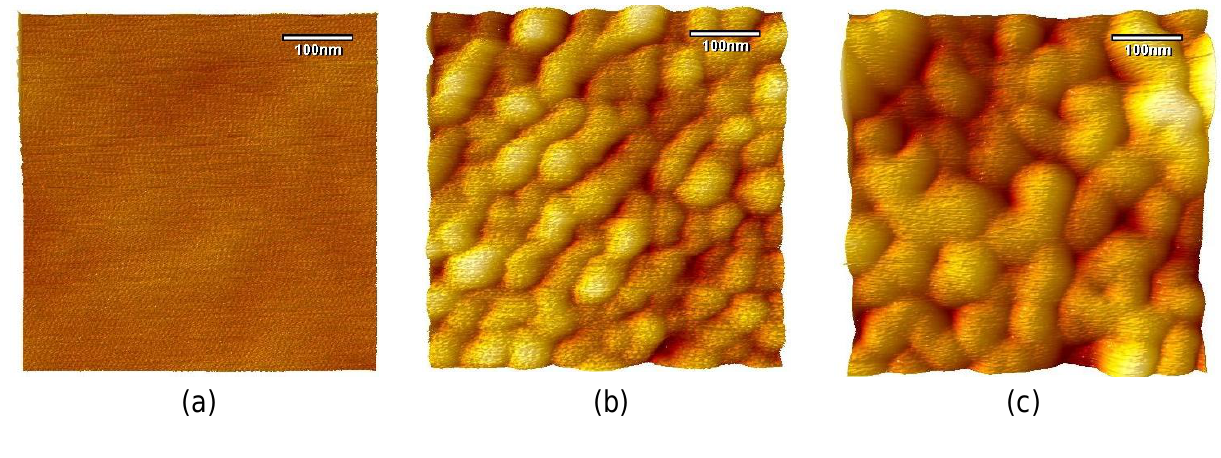
Figure 2. AFM images of (a) plain aluminum substrate, (b) nano-porous aluminum substrate, and (c)